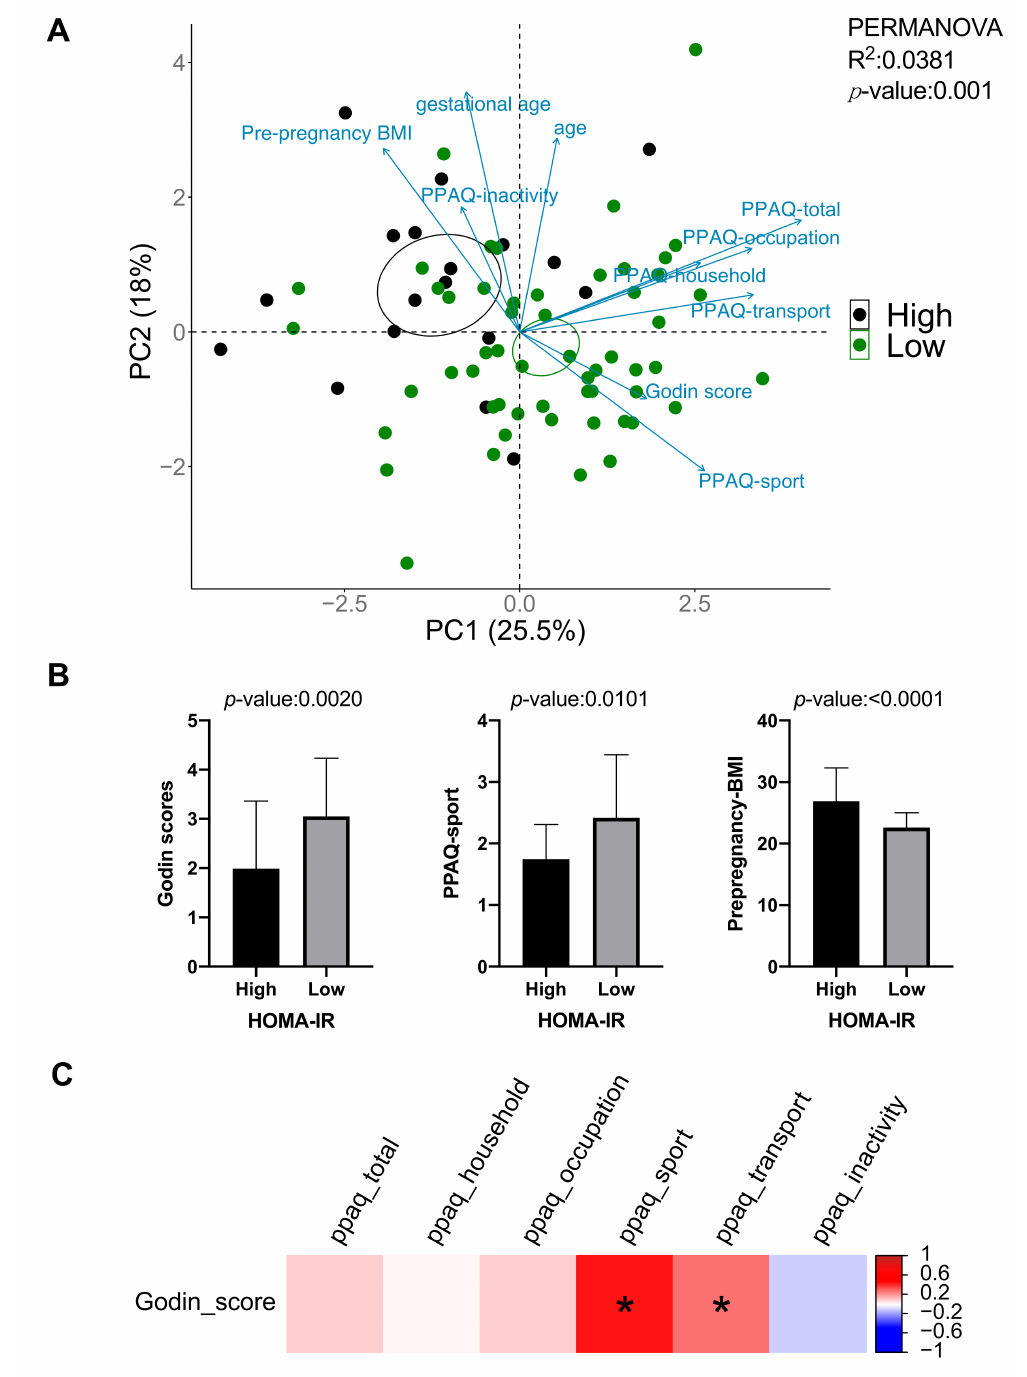
Figure 1. ( A ) Maternal physical activities and pre-pregnancy characteristics variables association with HOMR-IR in late pregnancy. A 2-dimensional scatter plot (PC1 vs. PC2) showing the variation of maternal physical activities and pre-pregnancy characteristics variables between high HOMA-IR group and low HOMA-IR group. The pre-pregnancy body mass index (BMI), exercise prior to pregnancy (Godin score), exercise during pregnancy (PPAQ-sport) variables are approaching 180 ◦ of separation, suggesting strong negative covariance between these variables contribute to the differentiation of high and low HOMA-IR scores. ( B ) Comparison of exercise prior to pregnancy (Godin score, cube root transformed), exercise during pregnancy (PPAQ-sport score, cube root transformed), and pre-pregnancy body mass index (BMI) between high HOMA-IR group and low HOMA-IR group. Statistical comparison between-groups were by unpaired t -test. ( C ) Associations between exercise prior to pregnancy and physical activities during pregnancy were assessed by Spearman rank correlation with FDR correction. * p <